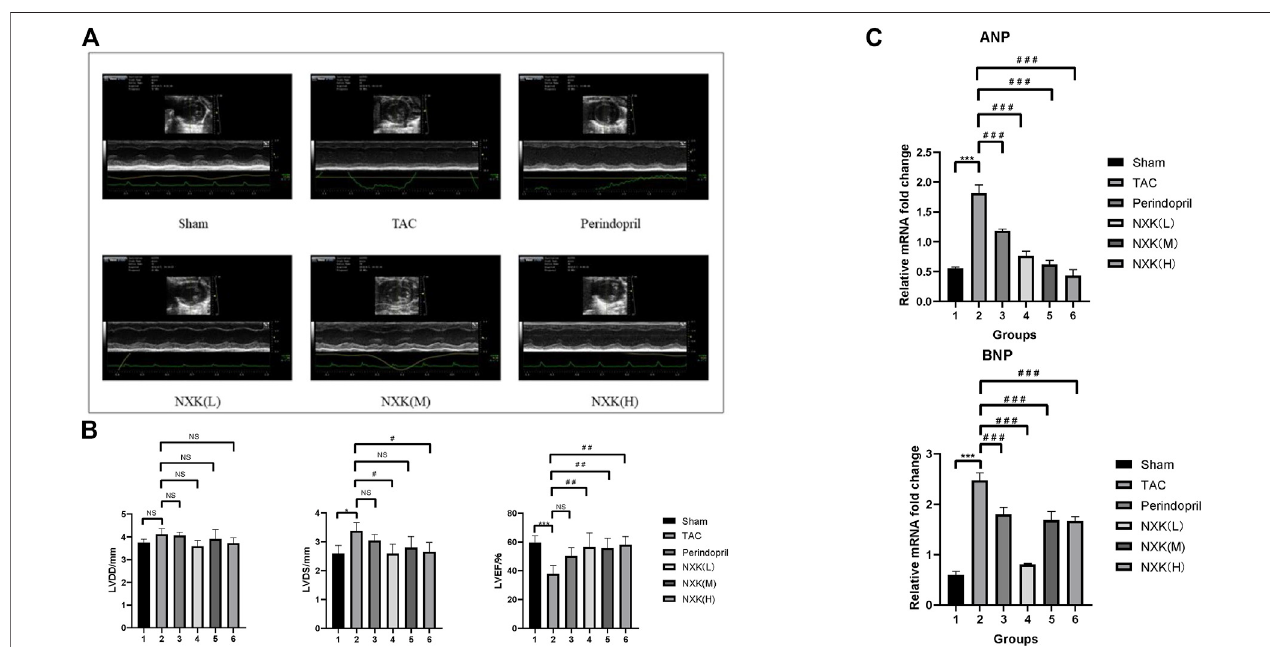
FIGURE 1 | NXK improves the cardiac function of mice with heart failure. (A) Representative M-mode images via echocardiography. (B) Representative cardiac function ( n = 10 per group). LVDD (mm), left ventricular end-diastolic dimension; LVDS (mm), left ventricular end-systolic dimension; LVEF (%), left ventricular ejection fraction. (C) mRNA expression levels of ANP and BNP were detected using RT-PCR. Quanti fi cation was performed after normalization to β -actin ( n = 10 per group). Values are shown as means ± SD, < 0.05, compared to the sham group * p < 0.05, ** p < 0.01, *** p < 0.001, compared to the Tac group # p < 0.05, ## p < 0.01, ### p < 0.001.